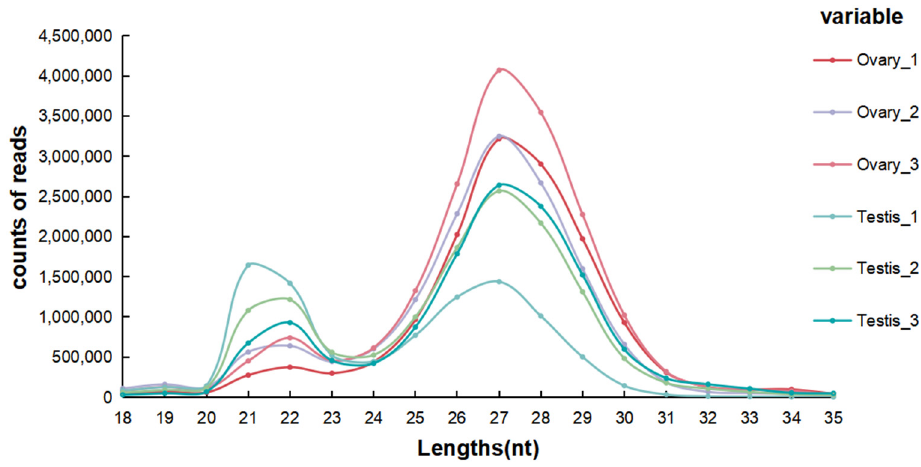
Figure 1. Read length distributions of the miRNAs in the six libraries.